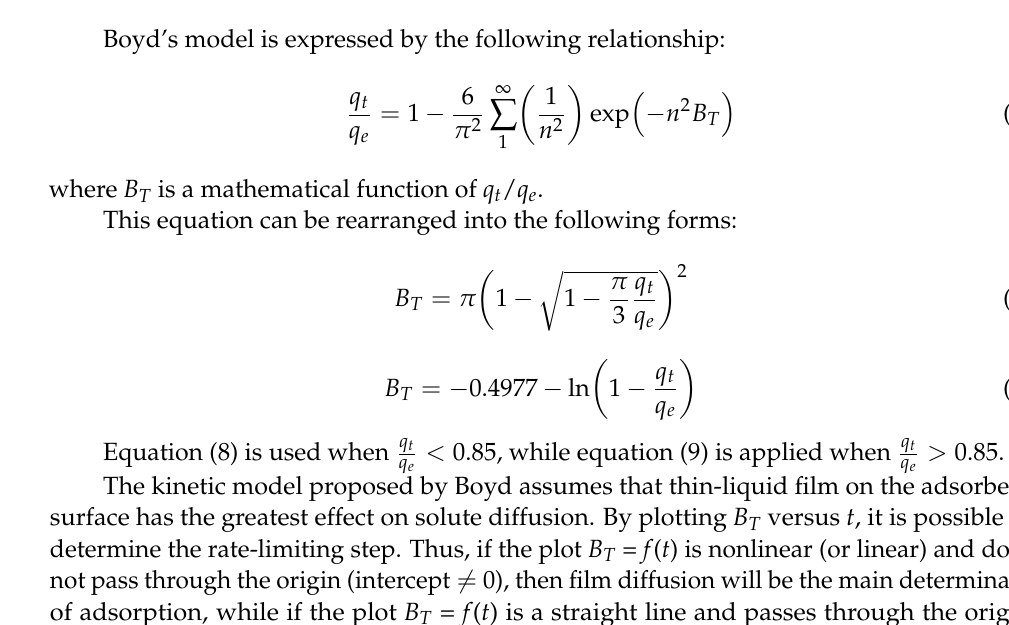
Figure 7. Weber – Morris diffusion model plots for adsorption of 2,4-D and MCPA on carbon black Figure 7. Weber–Morris diffusion model plots for adsorption of 2,4-D and MCPA on carbon black samples.